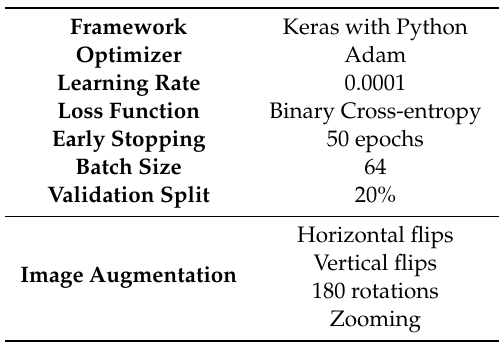
Table 2. The hyperparameters were used for all the